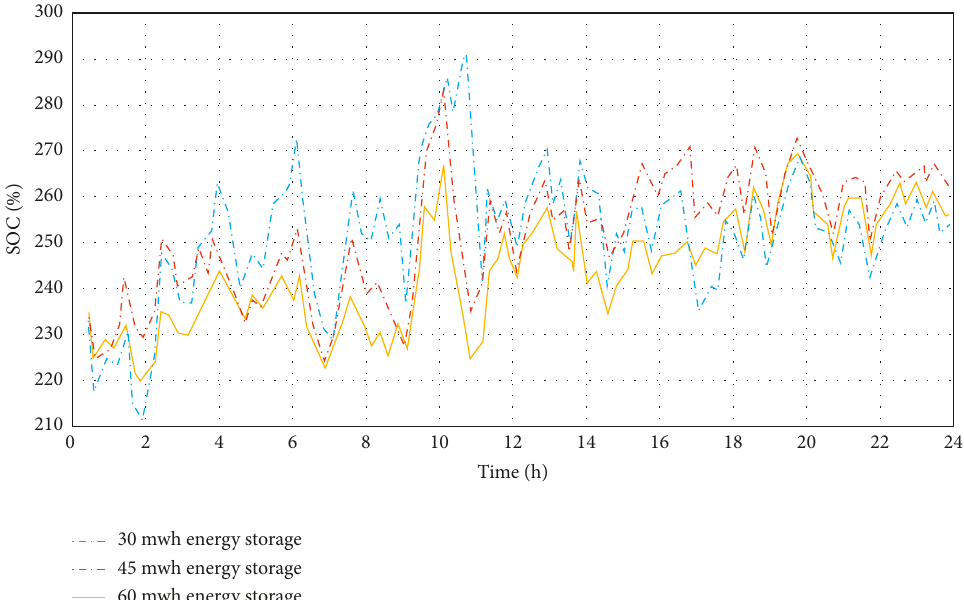
Figure 7: SOC fluctuation curve of energy storage